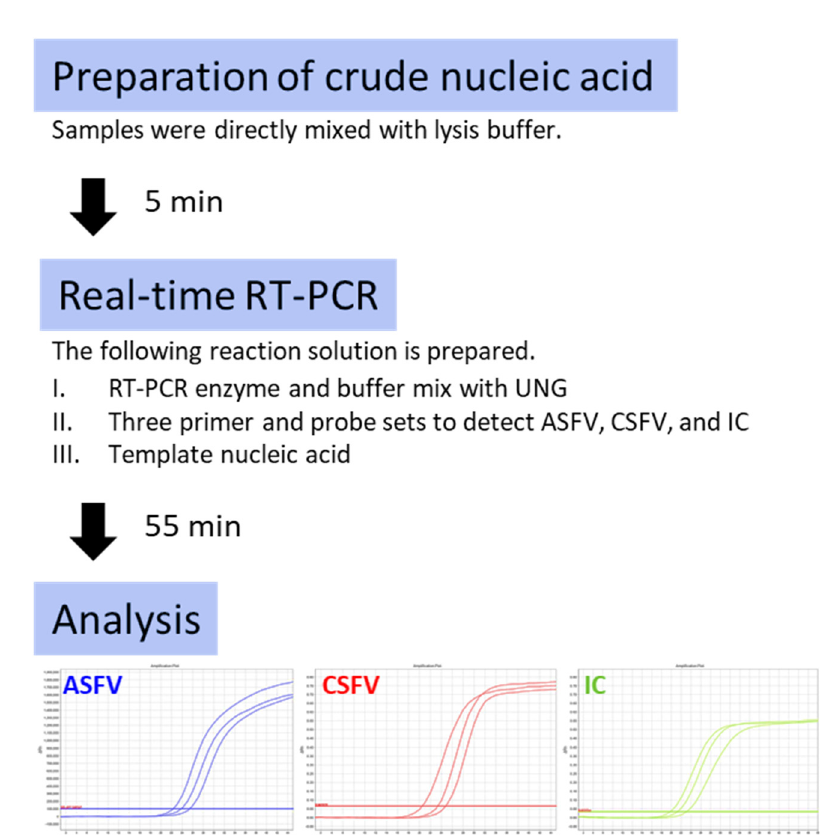
Figure 3. Outline of the direct-multiplex rRT-PCR system for the detection of ASFV and CSFV. The developed direct-multiplex rRT-PCR system requires only three steps to detect ASFV, CSFV, and IC.